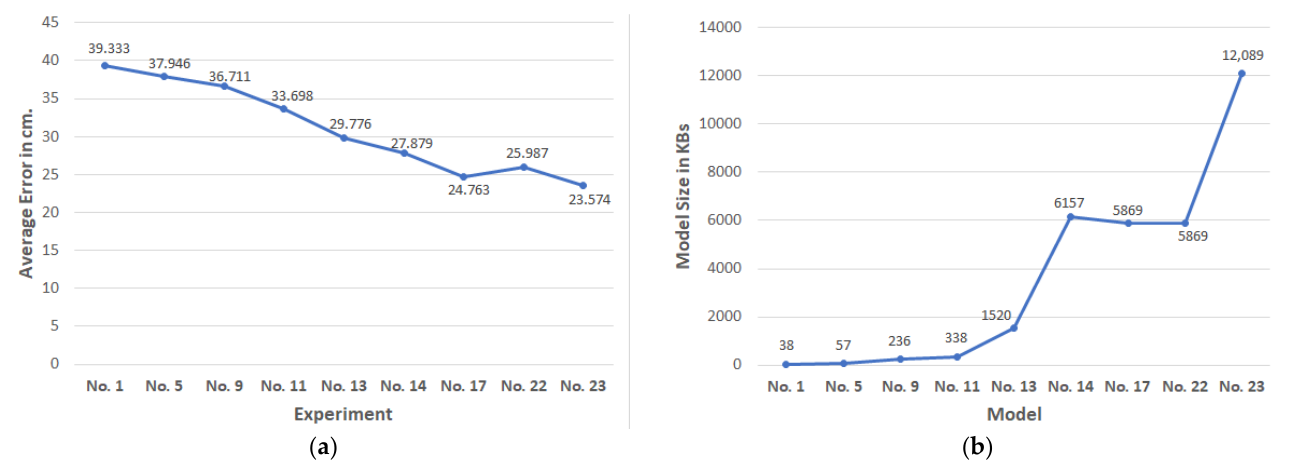
Figure 5. ( a ) Average error improvements for specific experiments; ( b ) models sizes for specific key models.